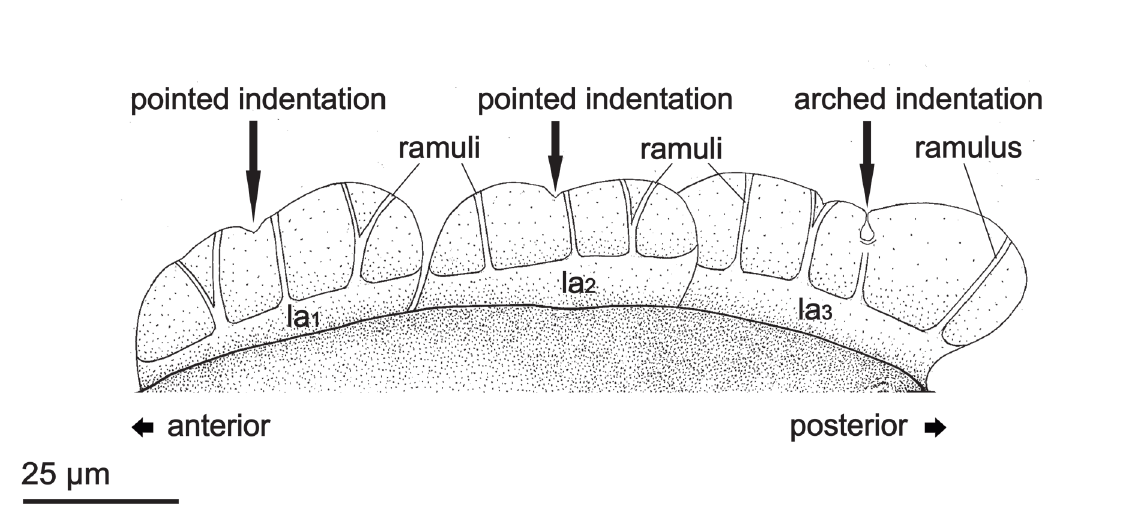
Fig. 1. General features of the lateral alae of Higginsarctus gen. nov. The procuticle sends out branches (ramuli) to the edge of the alae. Drawing by Stine B.